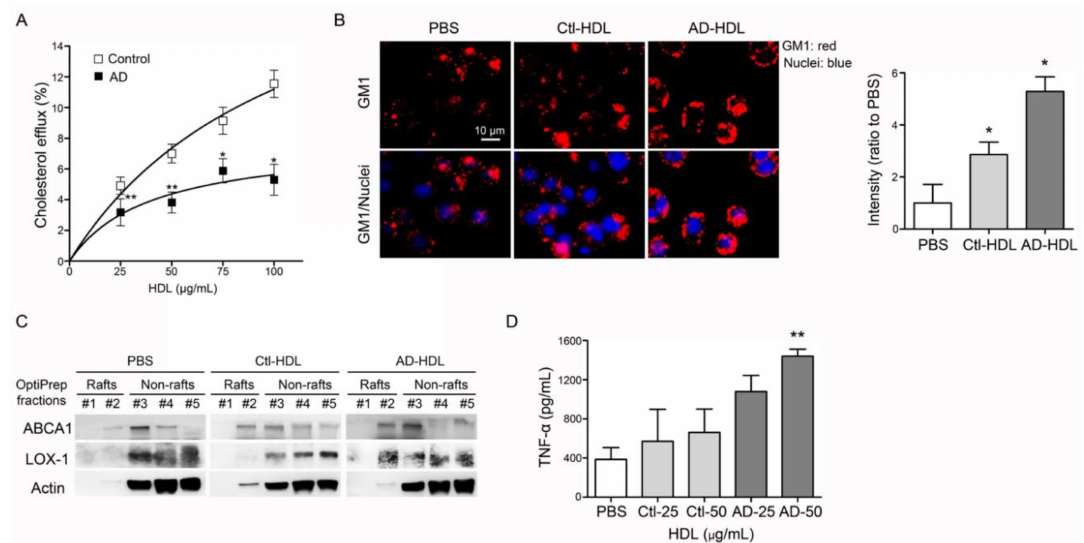
Figure 2. Analysis of function and proinflammatory properties of HDL. ( A ) Function of reverse cholesterol e ffl ux was decreased in HDL from AD patients. ( B ) AD-HDL induced vibrant expression of ganglioside GM1 on the membrane of marine macrophages, RAW 264.7 cells. AD-HDL enhanced the higher expression levels of ( C ) LOX-1 on the membrane and ( D ) TNF- α in the conditioned culture media. * p < 0.05, ** p < 0.01. Abbreviations. AD: Alzheimer’s disease; PBS: phosphate-bu ff ered saline; Ctl-HDL: HDL from controls; AD-HDL: HDL from AD patients; ABCA1: ATP-binding cassette, sub-family A member 1; LOX-1: lectin-type oxidized LDL receptor; TNF- α : tumor necrosis factor- α